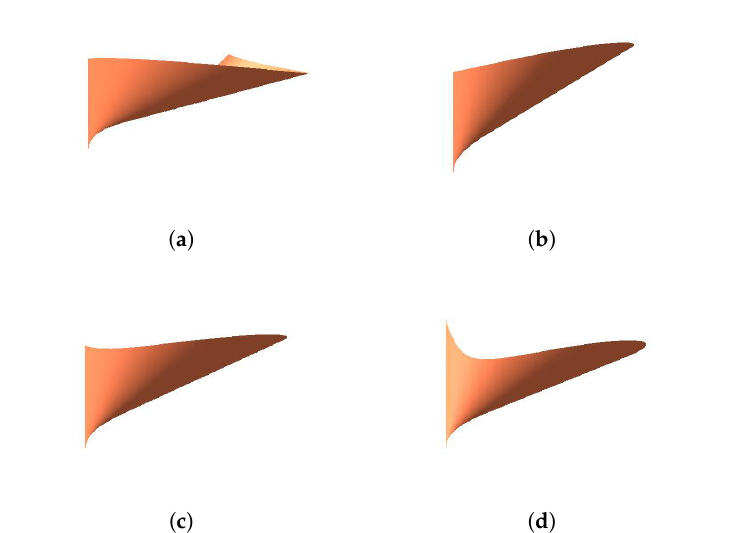
Figure 8. The effects of parameter α 2 on the tangent developable surface. ( a ) α 1 = π ( b ) α 1 = π